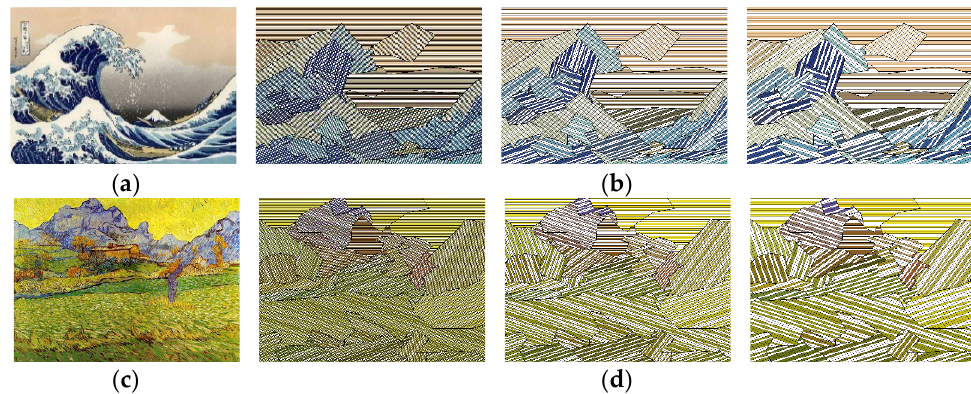
Figure 11. Results of data hiding in stripe-based Futurism-like images. ( a ) The original image, “The Great Wave off Kanagawa,” by Katsushika Hokusai, 1831. ( b ) Three stripe-based Futurism-like images with message data embedded with Figure 4a as the input. ( c ) The second original image, “A Meadow in the Mountains,” by Vincent van Gogh, 1889. ( d ) Three stripe-based Futurism-like images with message data embedded with Figure 4c as the input.